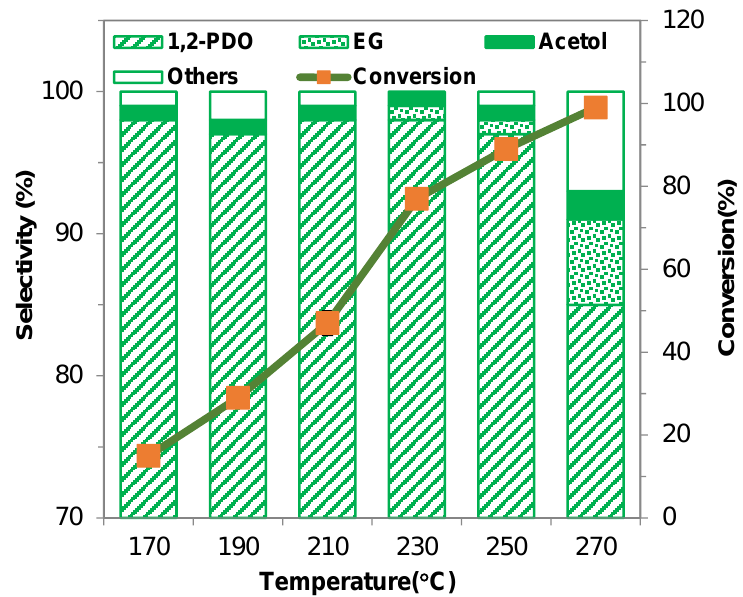
Figure 5. Influence of temperature on the activity of 5Cu-1B/Al 2 O 3 catalyst for glycerol hydrogenolysis (5 MPa H 2 , 10 wt% aq. glycerol and WHSV 0.2 h −1 ).